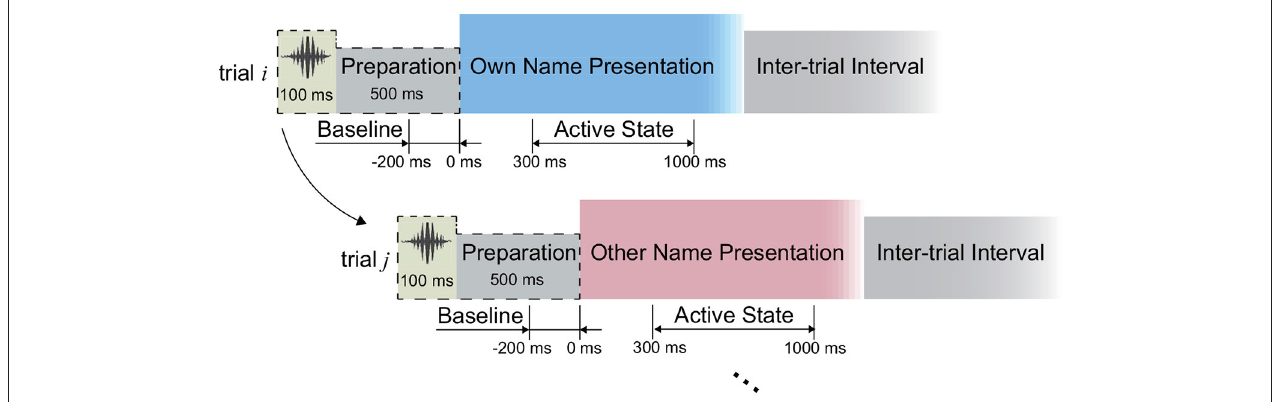
FIGURE 2 | Experimental paradigm. The periods from the 300 to 1,000 ms following the stimuli onsets were defined as active states during the signal processing.